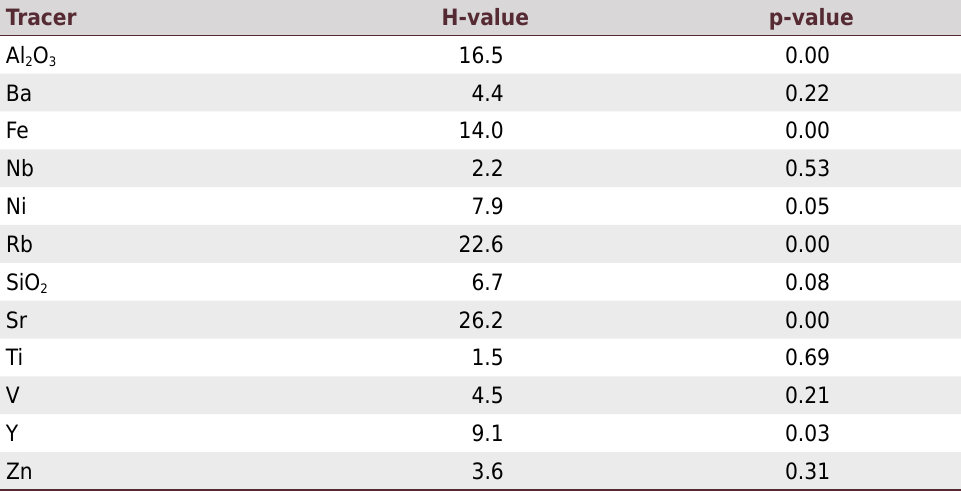
Table 2. Efficacy of the individual geochemical tracer elements in distinguishing the sediment sources in relation to land use in the Posses catchment, evaluated through the H test of Kruskal- Wallis. Acceptance requires a